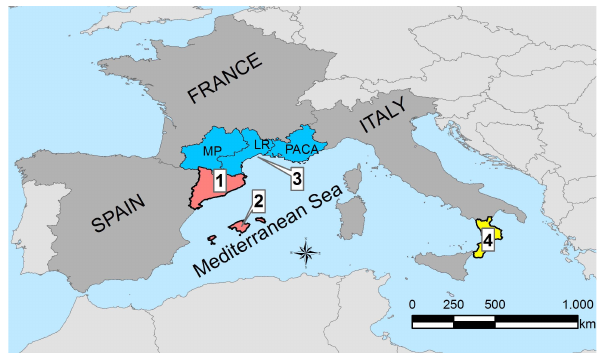
Fig. 1. Selected regions for building the preliminary HYMEX